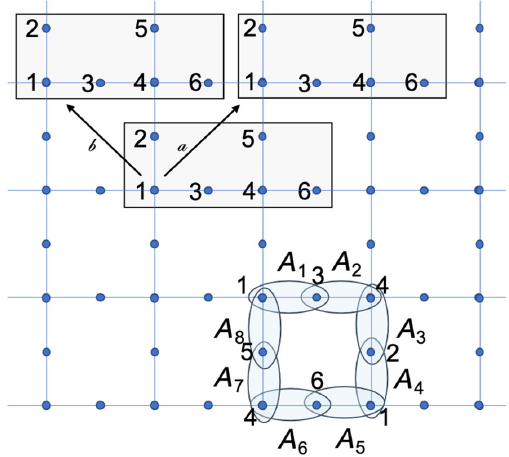
FIG. 3. The unit cell for the measurement driven Lieb lattice dynamics consists of two Lieb lattice unit cells. A choice for such a dynamical unit cell is